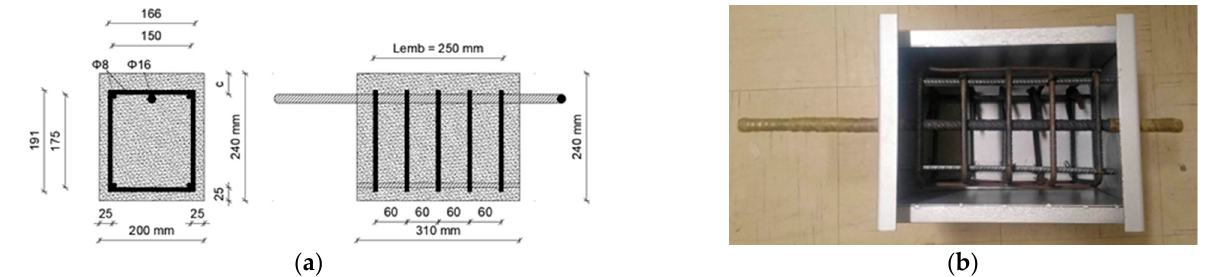
Figure 2. ( a ) Typical geometry of specimen and ( b ) installation of steel reinforcement in the molds.